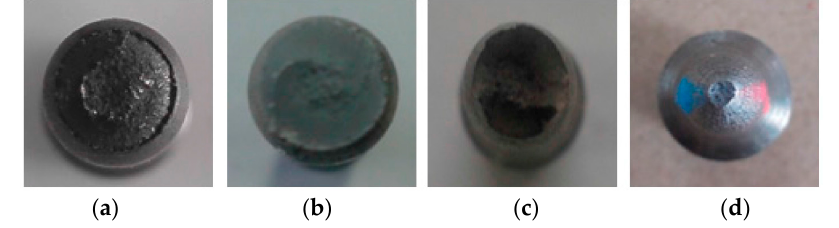
Figure 4. Failure modes under tension. ( a ) Q235; ( b ) AL6061; ( c ) SS316; ( d ) LYS160.